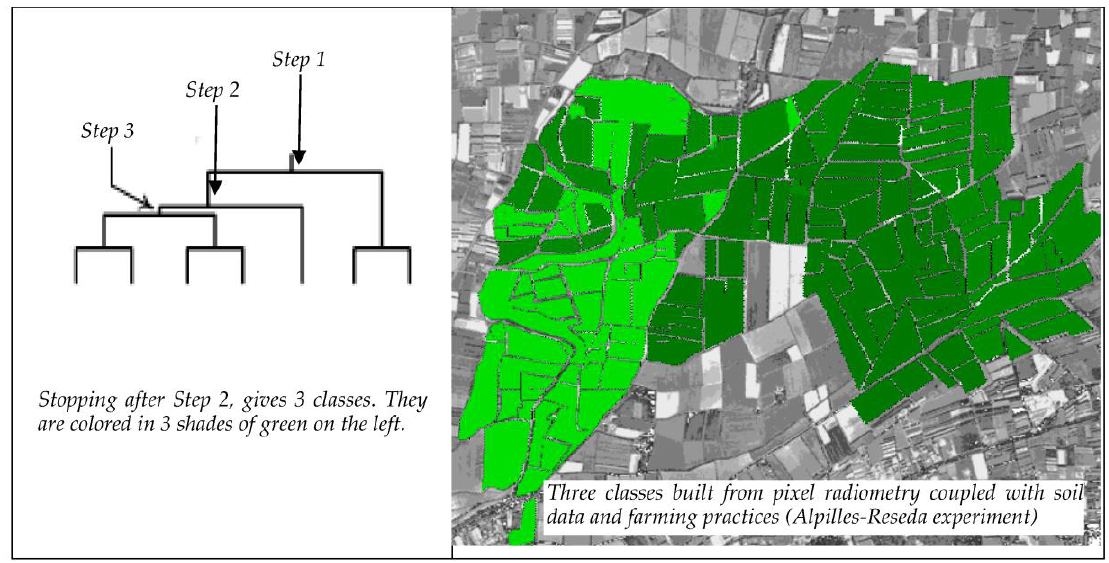
Figure 4. Hierarchical clustering example (sometimes referred to as phylogenetic tree).